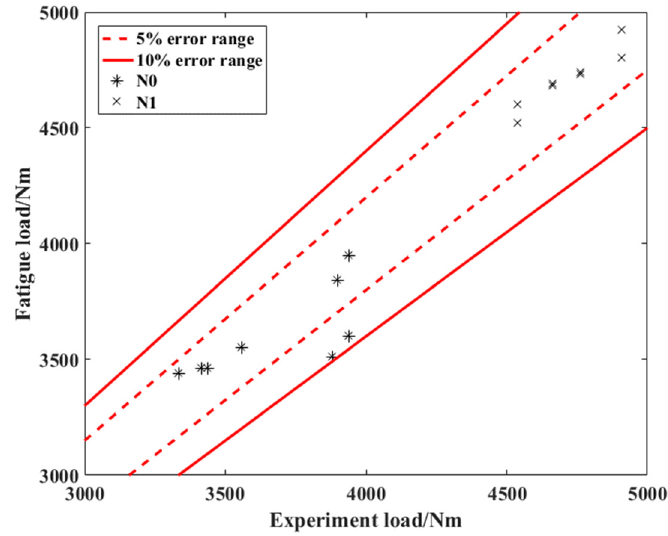
Figure 19. Fatigue load predictions of both crankshafts.